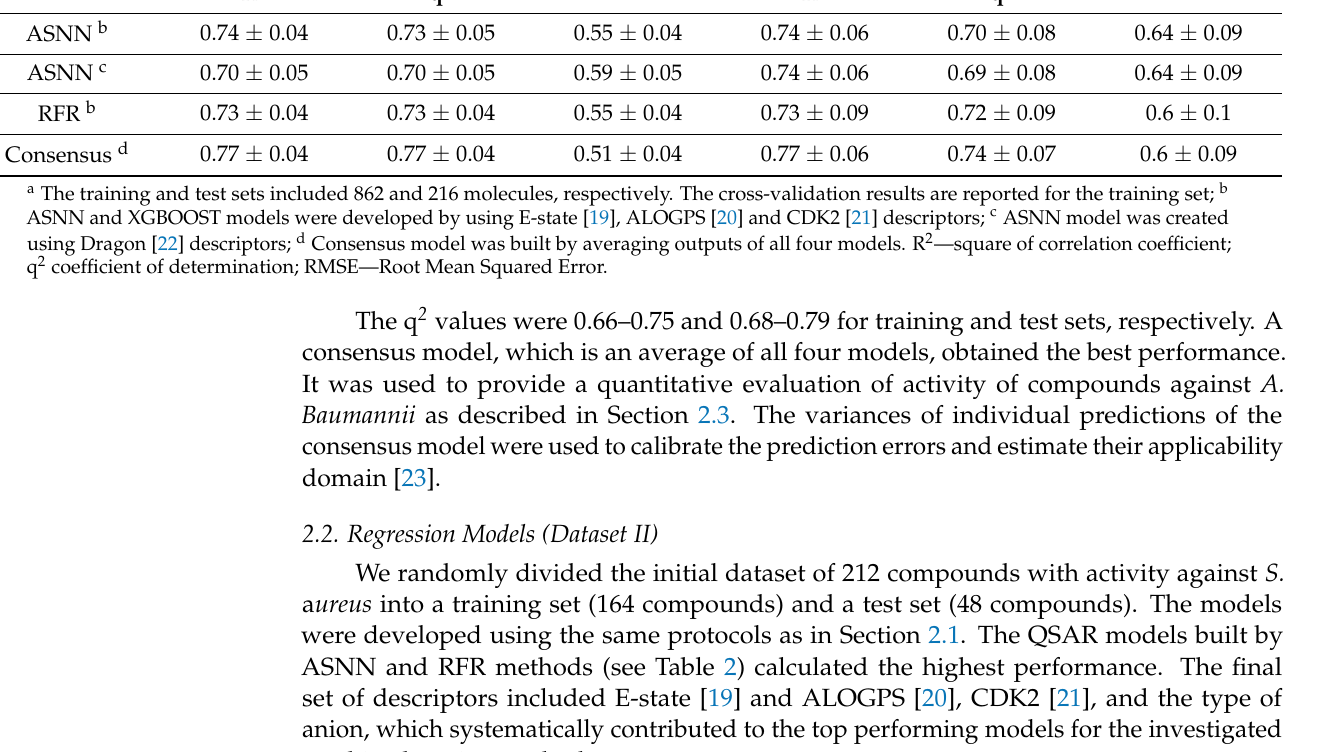
Table 1. Statistical coefficients calculated for QSAR models obtained for dataset I with activity against A. baumannii . Method